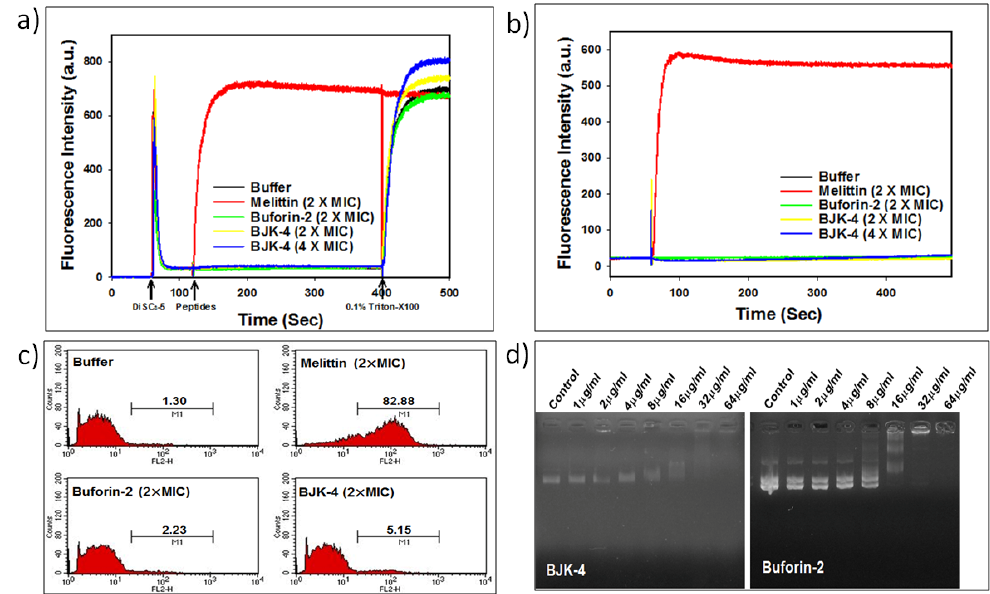
Figure 6. ( a ) Determination of cell membrane depolarization of S. aureus , KCTC 1621 using the membrane potential-sensitive fluorescent dye DiSC3-5. ( b ) Cell membrane permeability of S. aureus , KCTC 1621 using SYTOX Green assay. ( c ) Cell membrane permeabilization of E. coli , KCTC 1682 using Flow cytometry. ( d ) The influence of BJK-4 and buforin-2 on the migration of plasmid DNA through the agarose gel.